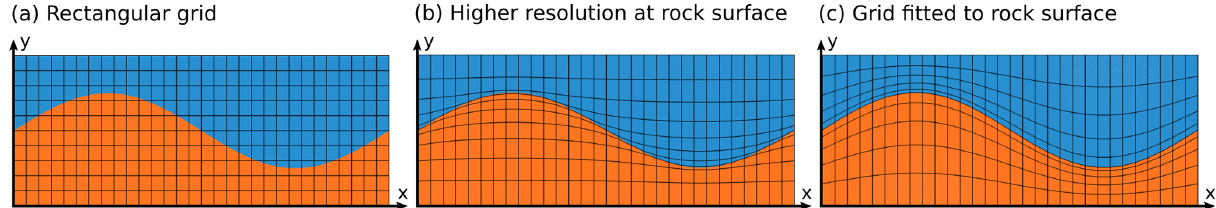
Figure 4. (a) Rectangular mesh. (b) Structurally conforming mesh, with increased resolution at the ice–rock interface. (c) Mesh perfectly fits the rock surface. Blue: ice. Red: bedrock. For visualization purposes, both mesh resolution and distortion are reduced compared to the actual experiments. The structure parameter m = 0 . 5 for both adapted grids (see Eqs. 14, 15). Mesh resolution: x = 128, y = 64. In the case of the rectangular mesh, it is additionally 256 × 128.